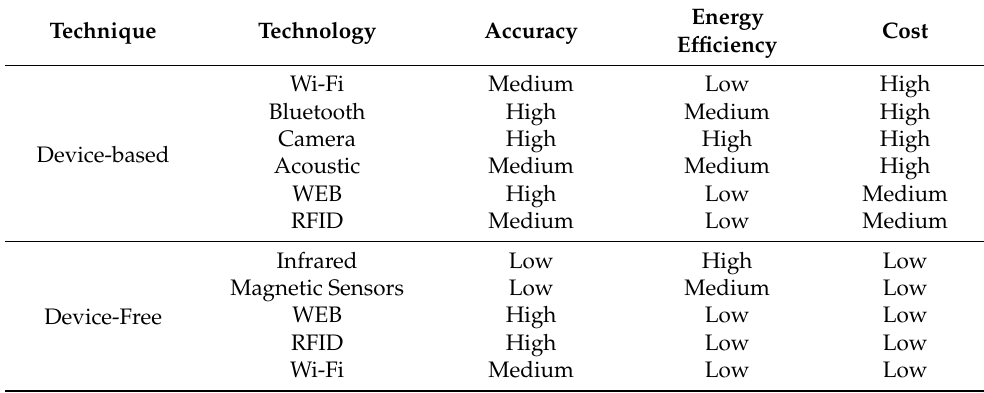
Table 3. Summary of device-based and device-free localization techniques.